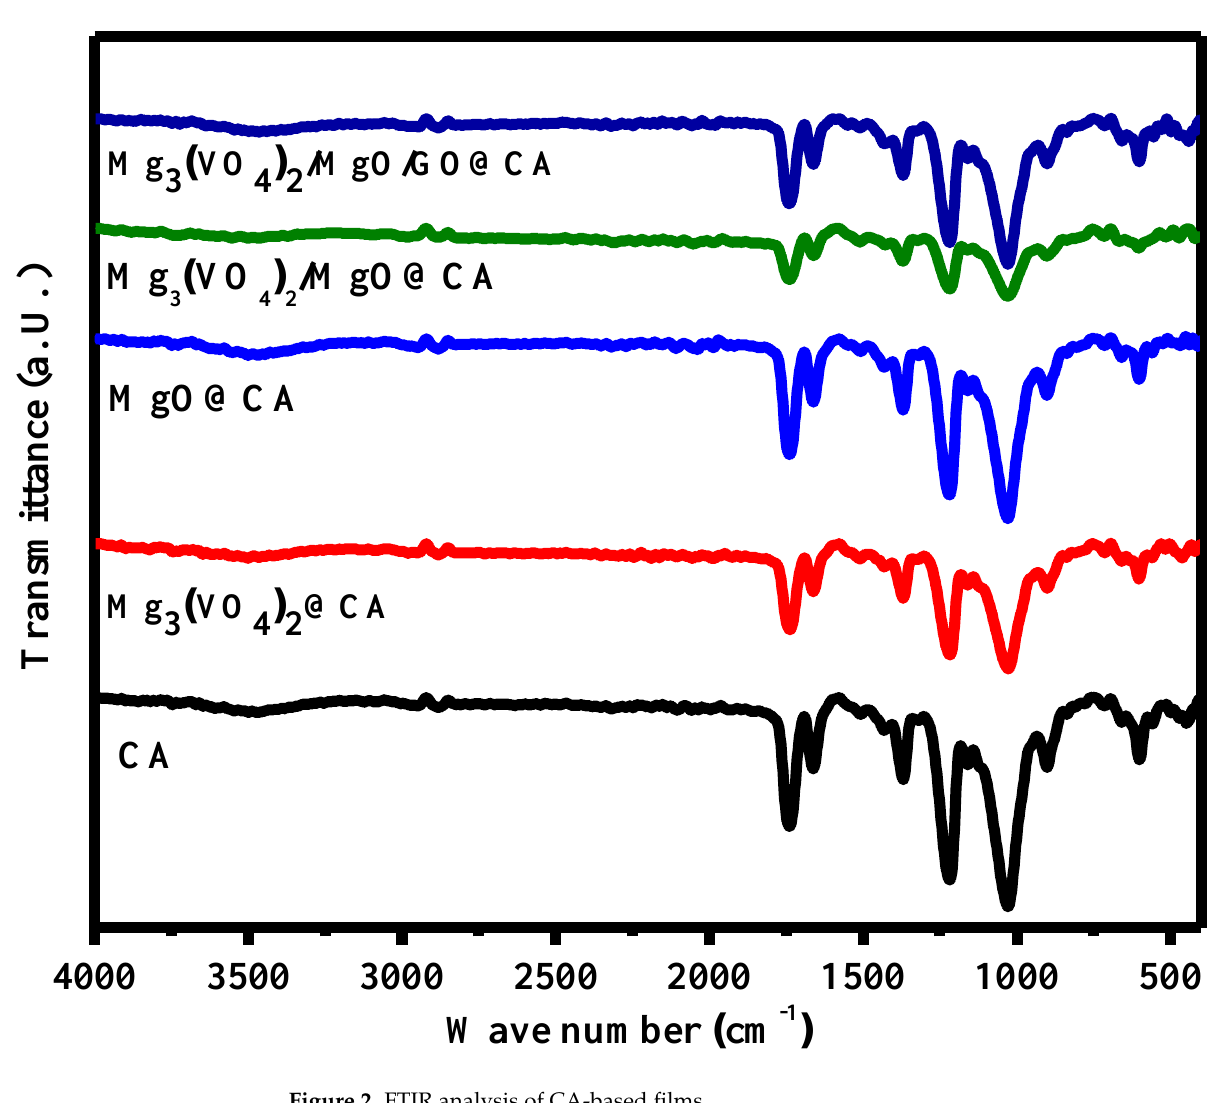
Figure 2. FTIR analysis of CA-based films.